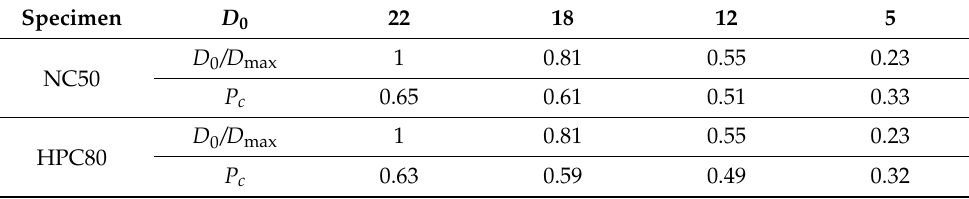
Table 4. Distribution probability of particle size of each aggregate in the specimens NC50 and HPC80.